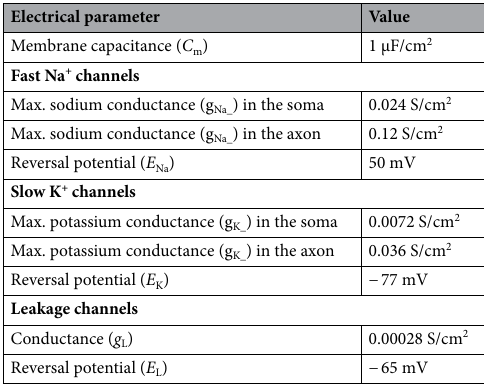
Table 1. Electric parameters of the NEURON model for an Aplysia neuron that contains a soma and an axon. t: environmental temperature in degrees Celsius. v: membrane potential of a neural segment in